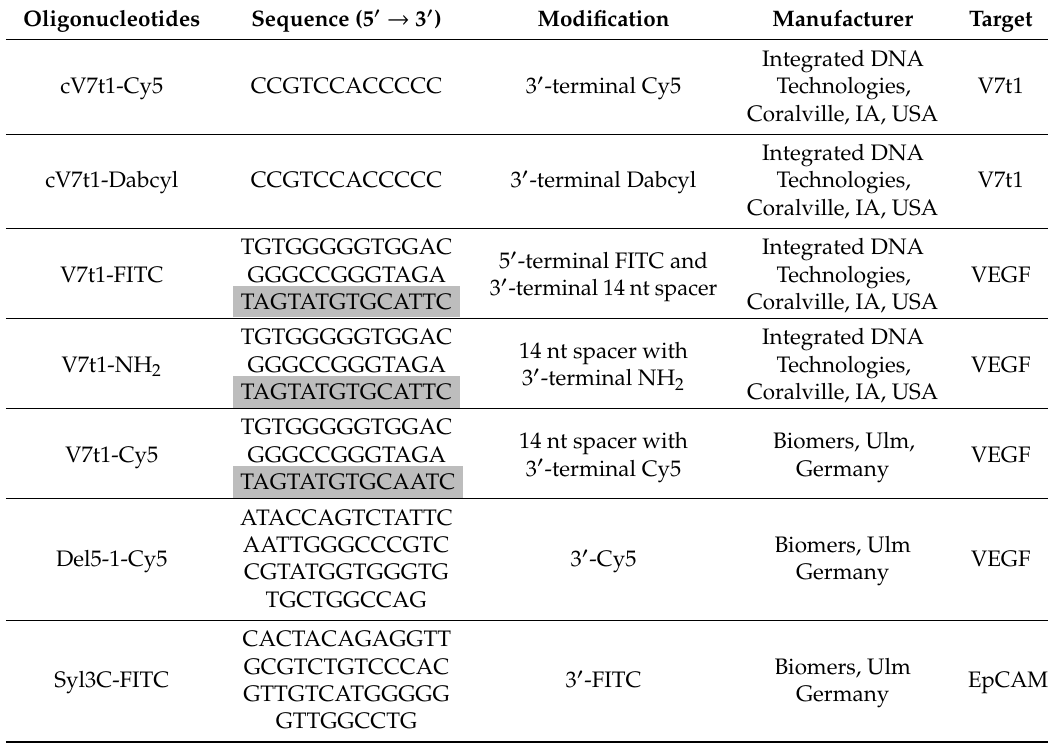
Table 1. Oligonucleotide sequences with type and position of modification, their corresponding target and